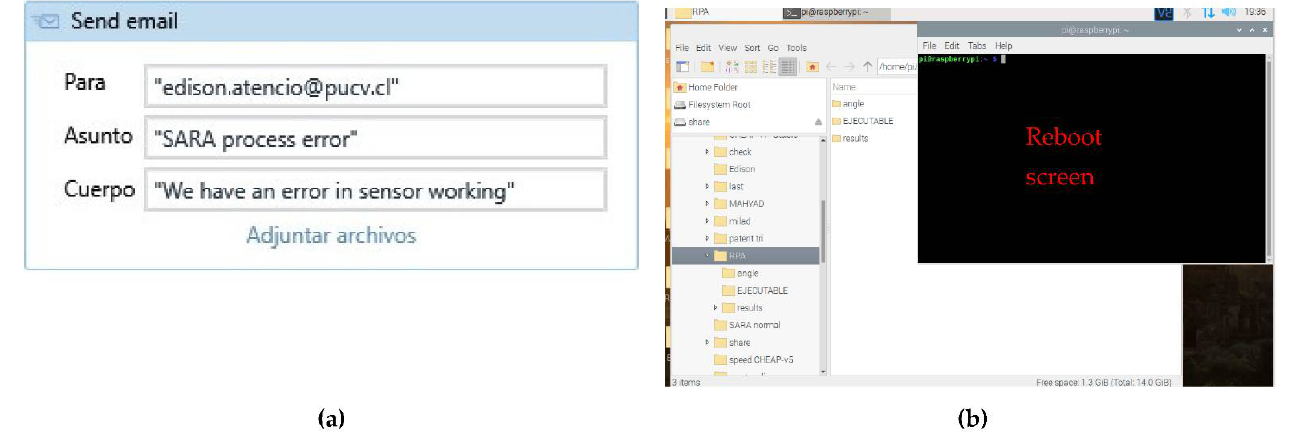
Figure 11 . Tasks for error processing. ( a ) Email notification. ( b ) Rebooting process.